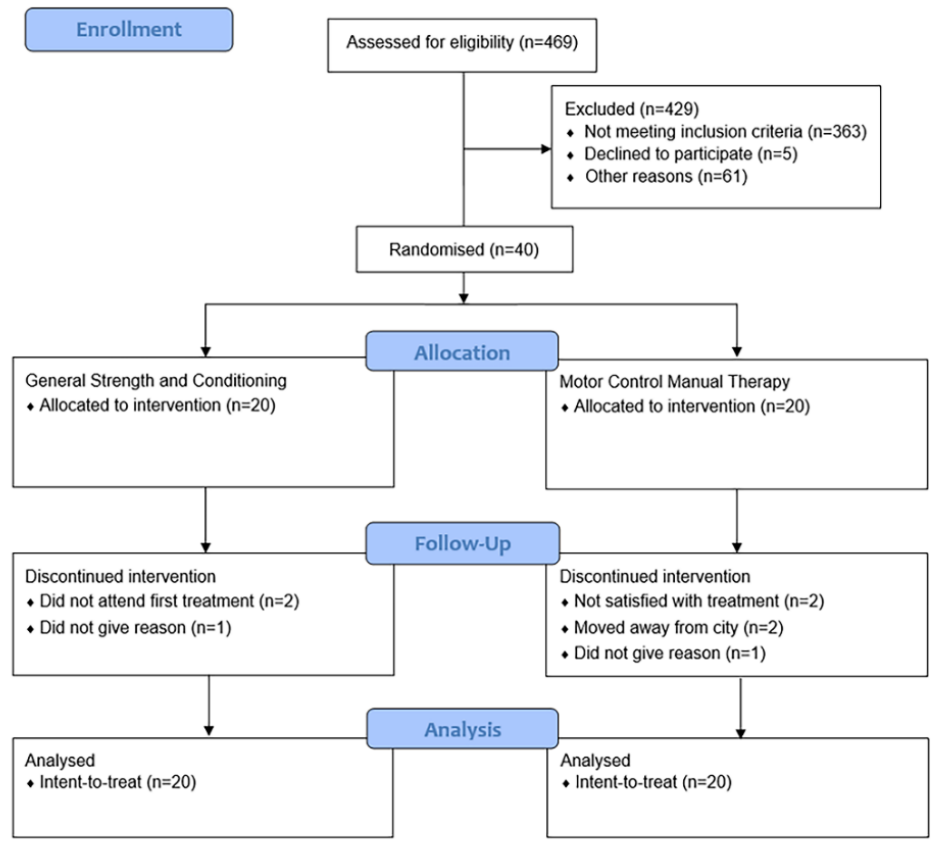
Figure 2. CONSORT Figure 2. CONSORT diagram.